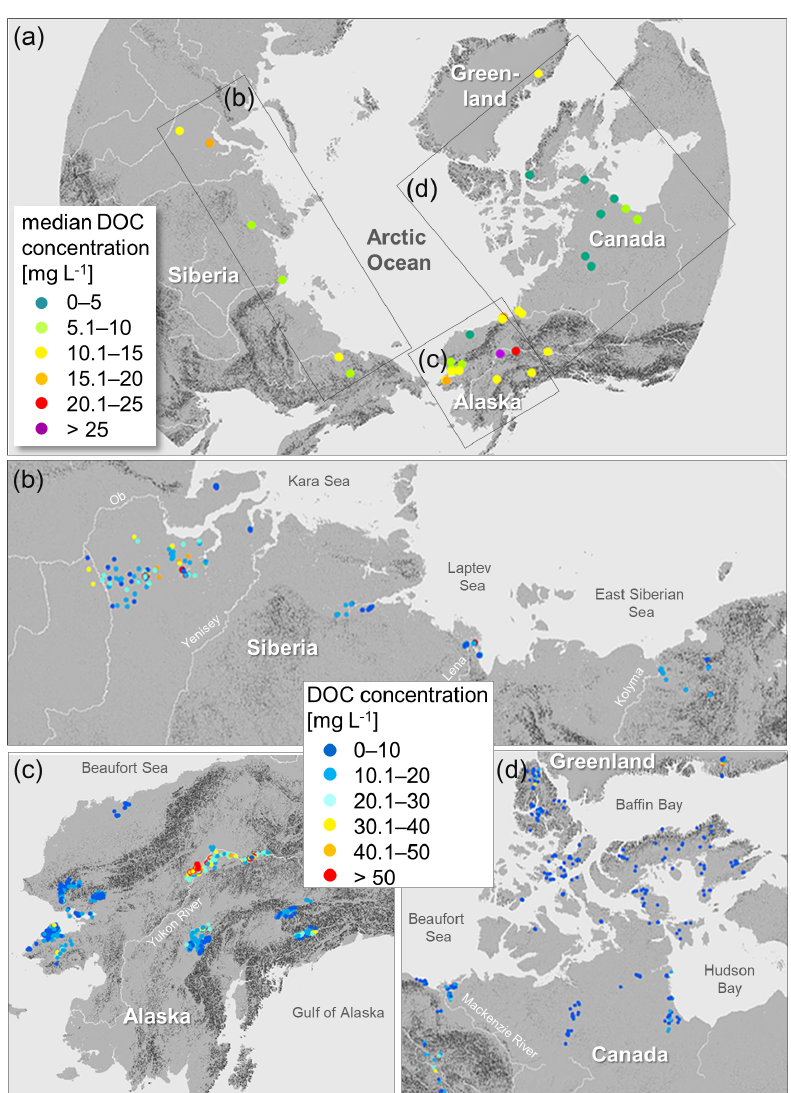
Figure 2. Map of lake DOC concentrations (mgL − 1 ) and regional variability. Median DOC concentration for each study site (a) . DOC concentrations of individual lakes in the study regions Siberia (b) , Alaska (c) , and Canada and Greenland (d) (background map: Esri). Table 4. Results of the Spearman rank correlation, testing the relationship between lake DOC concentration and lake parameters. Latitude Permafrost Ecoregion Ground ice Deposit SOCC SOCC zone content type